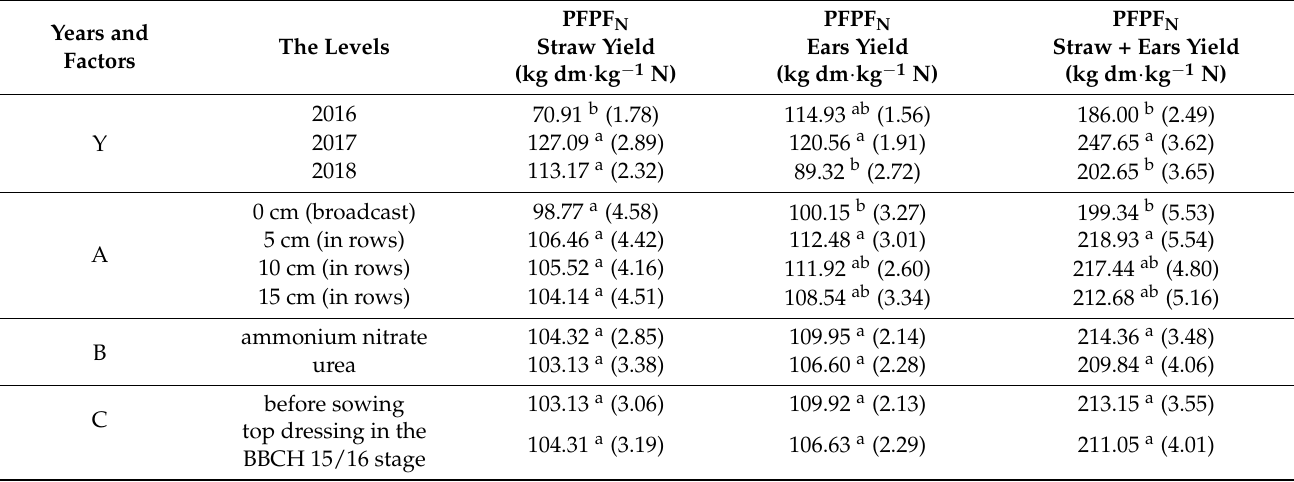
Table 11. Mean values of the traits for the years (Y) and NP fertilizer sowing depth (A), type of supplementary nitrogen fertilizer (B), date of supplementary nitrogen fertilization